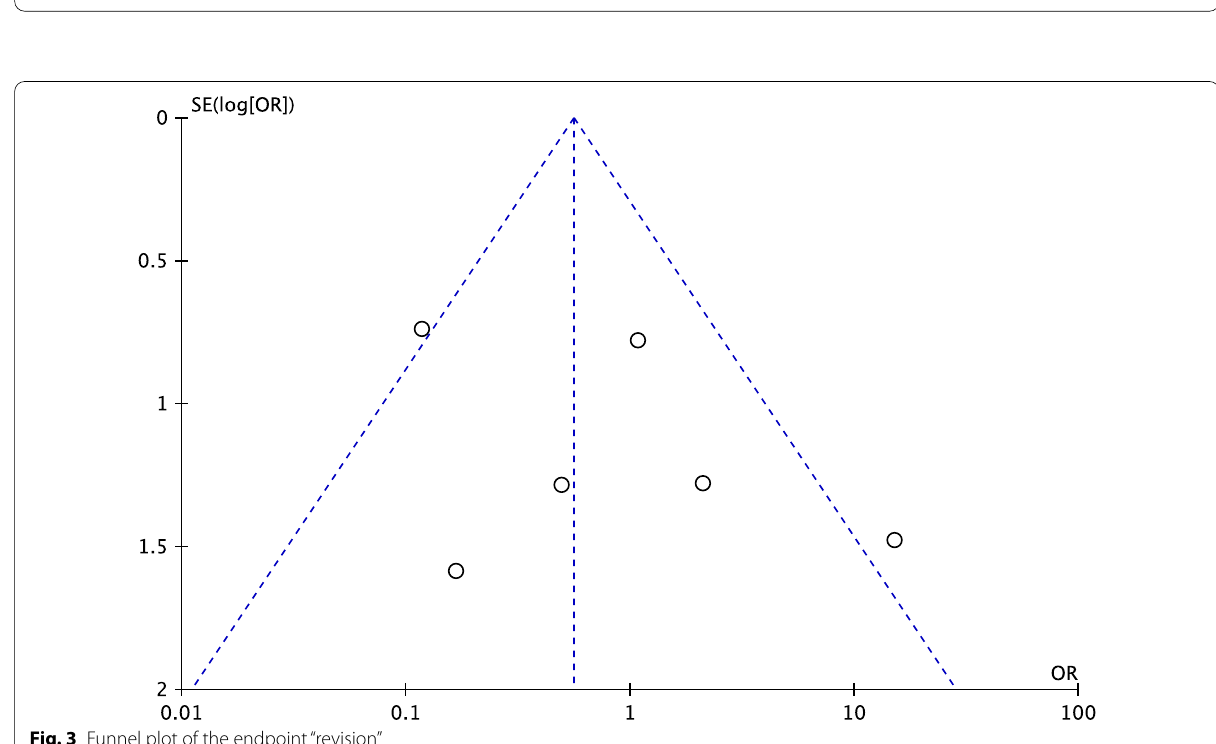
Fig. 3 Funnel plot of the endpoint